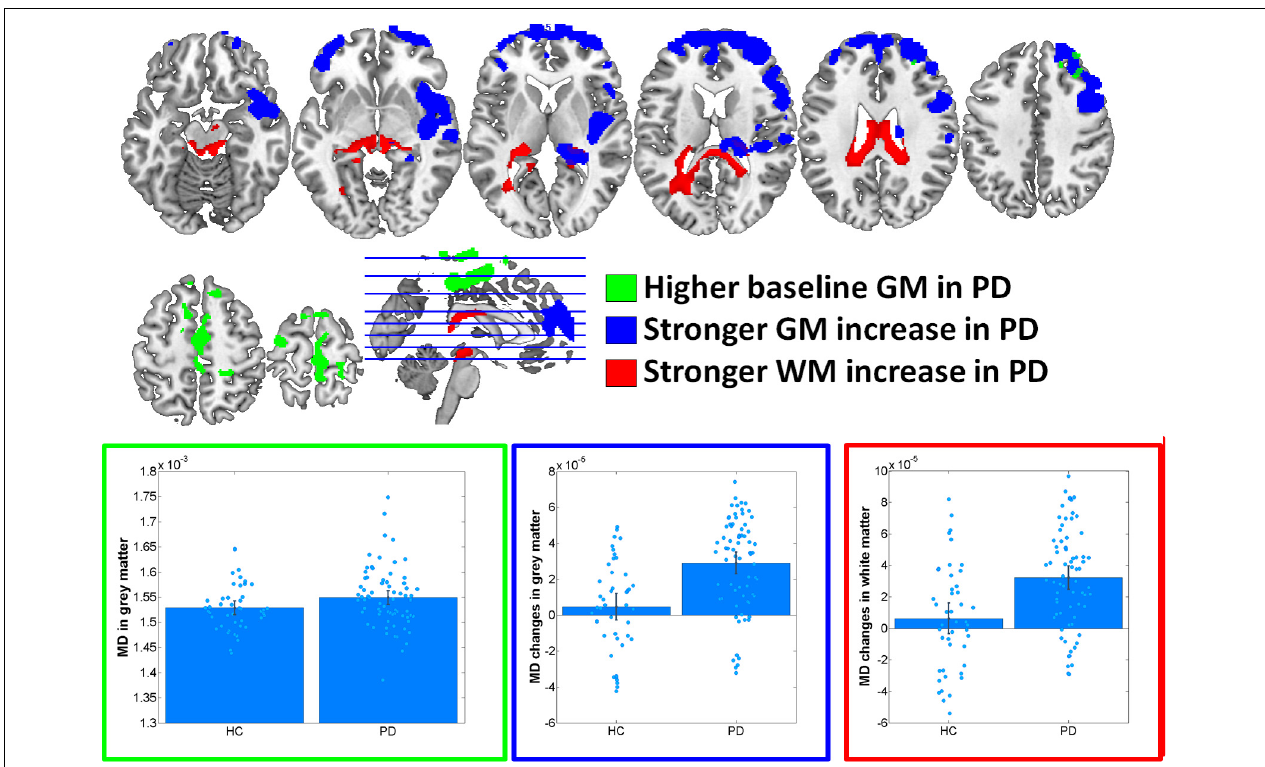
FIGURE 2 | Results of voxel-based morphometry analyses of mean diffusivity (MD) maps. Bar plots show the eigenvariates extracted from the displayed significant clusters. Outline colors of the bar plots correspond to the contrast colors of respective clusters. HC, healthy control participant; PD, Parkinson’s disease patients; GM, gray matter; WM, white